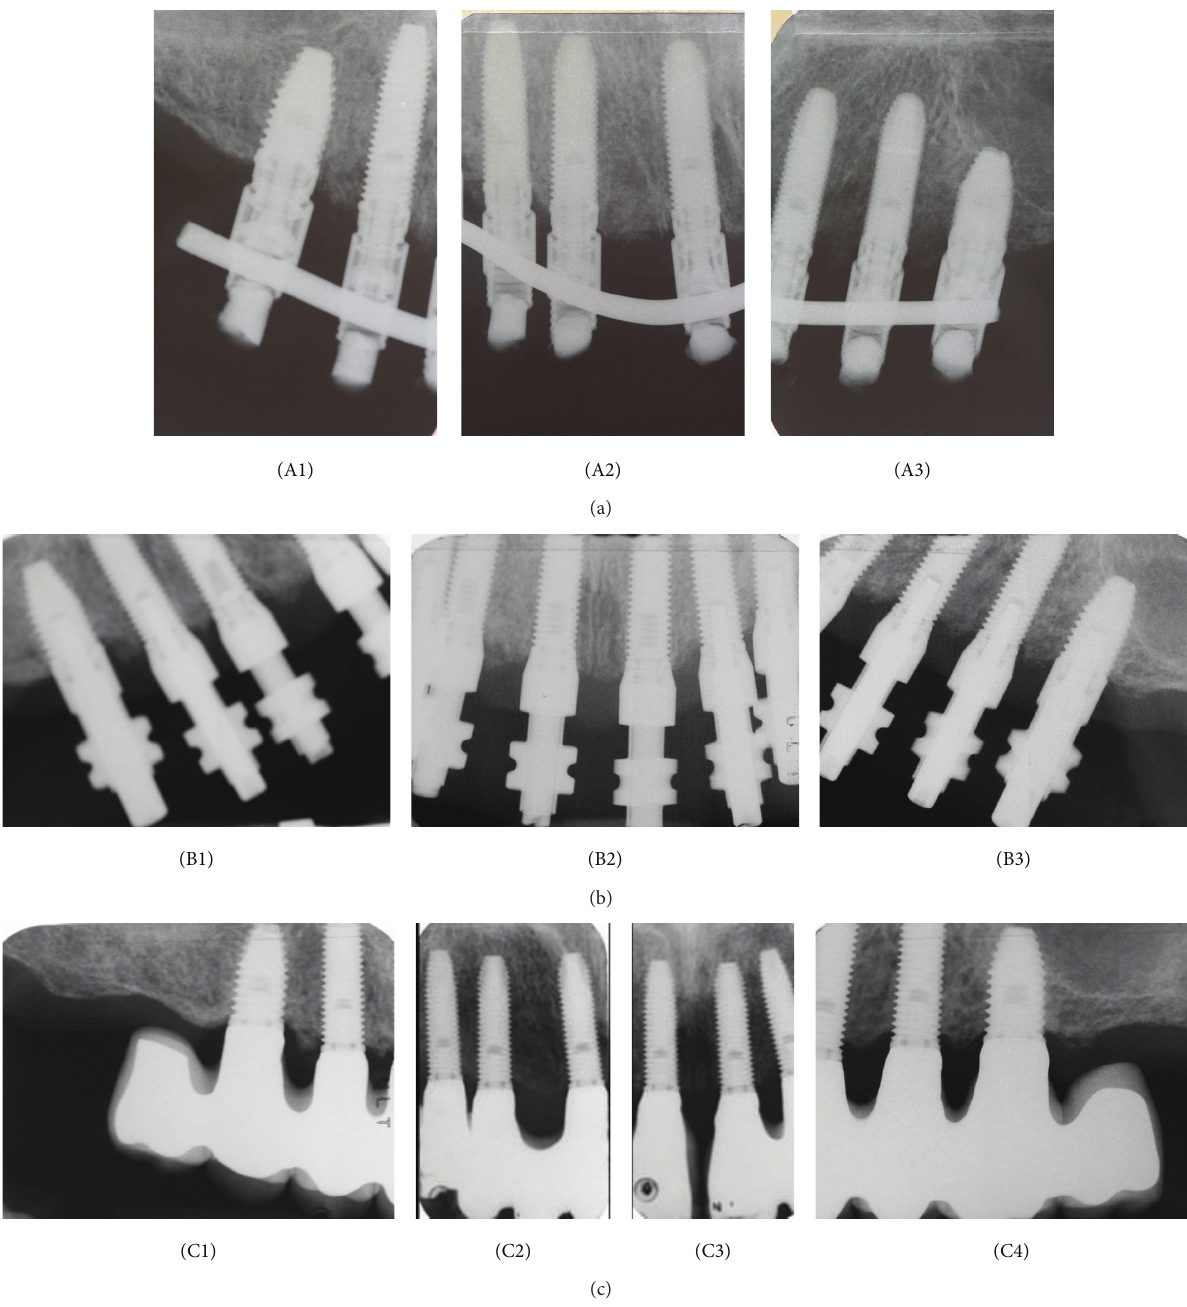
Figure 8: Radiographic examination: (A1), (A2), and (A3): postoperative radiographs. (B1), (B2), and (B3): at 6 months during the impression for the final restoration. (C1), (C2), (C3), and (C4): 18 months after the